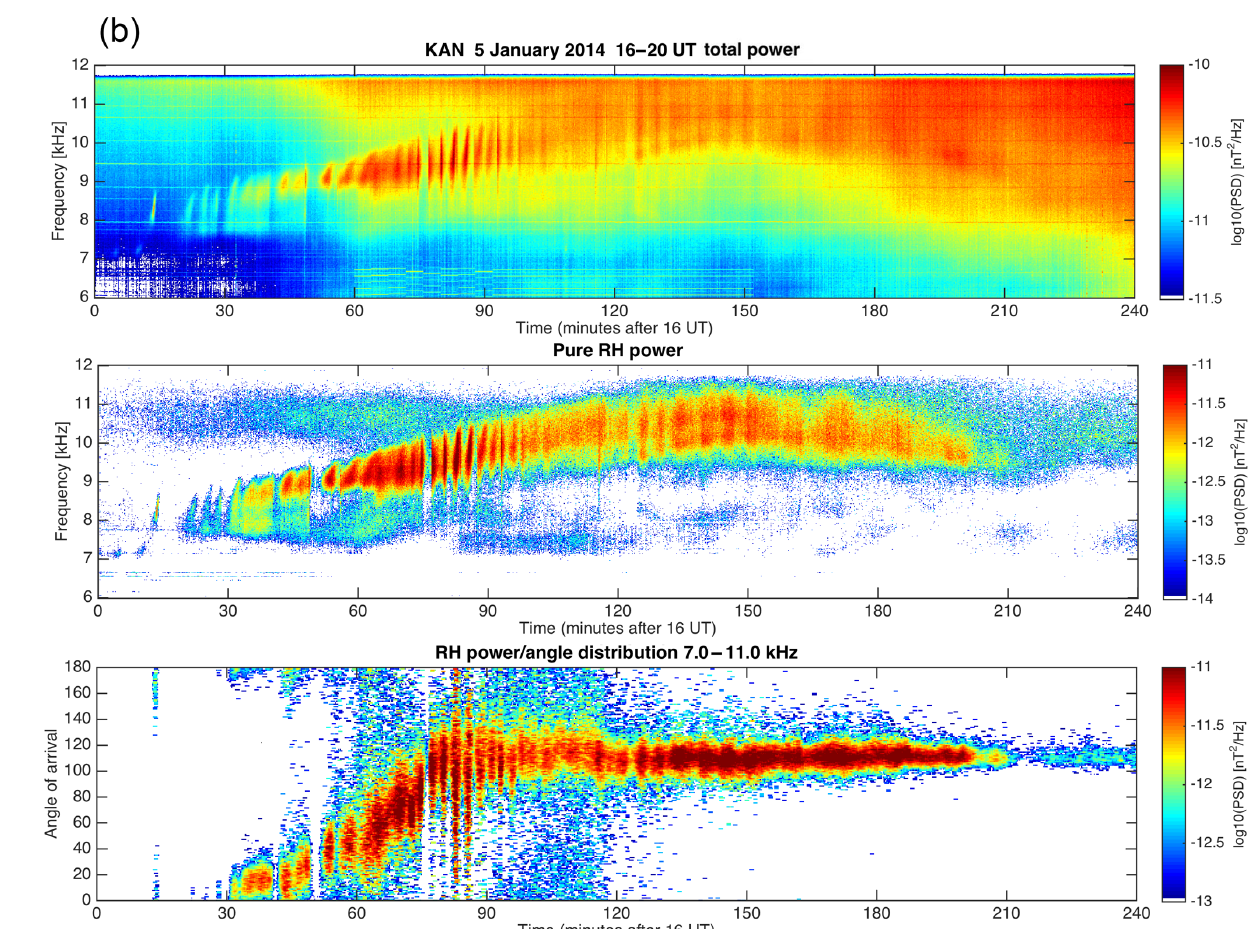
Figure 2. (a) The 4h VLF spectrograms at 6–12kHz: total power (uppermost panel), right-handed power (second panel), the wave power/angle distribution based on pure right-hand power at 9.0–10.5kHz (third panel) and 7.0–8.5kHz (lowermost panel) on 25 Decem- ber 2011. Color bars represent the signal power (in log10(PSD), in nT 2 Hz − 1 ). (b) The 4h VLF spectrograms at 6–12kHz: total power (uppermost panel), right-handed power (middle panel), the wave power/angle distribution based on pure right-hand power at 7.0–11.0kHz (lowermost panel) on 5 January